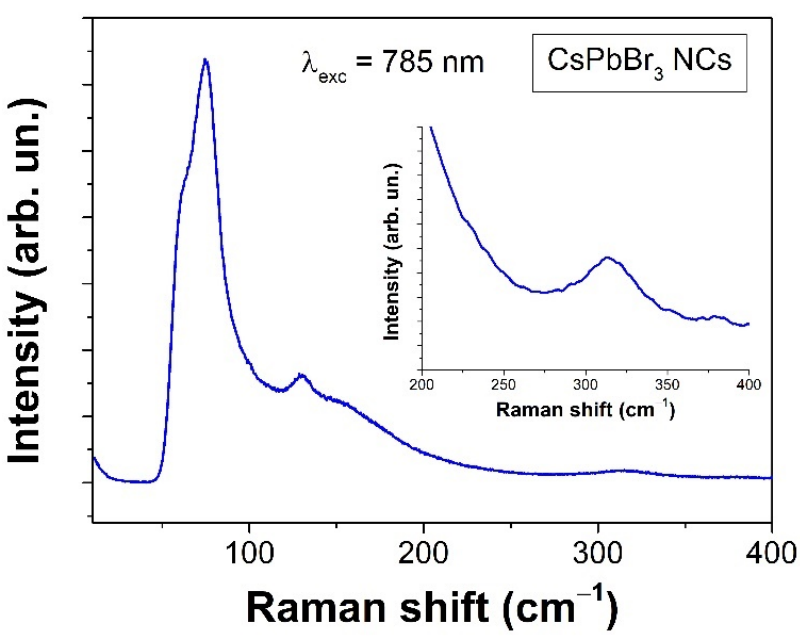
Figure 3. Raman spectrum of nanocrystal precipitate; in the inset is a magnified view of the region of 200–400 cm −1 . Note: λ exc = 785 nm.